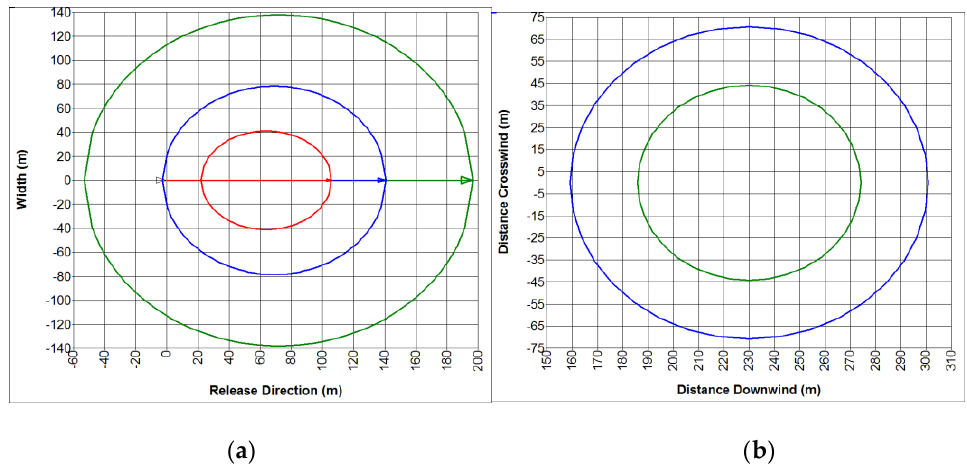
Figure 19. Hazard zones due to a jet fire ( a ) and an explosion ( b ) for a natural gas pipeline (a = 0.2, p = 1 MPa).